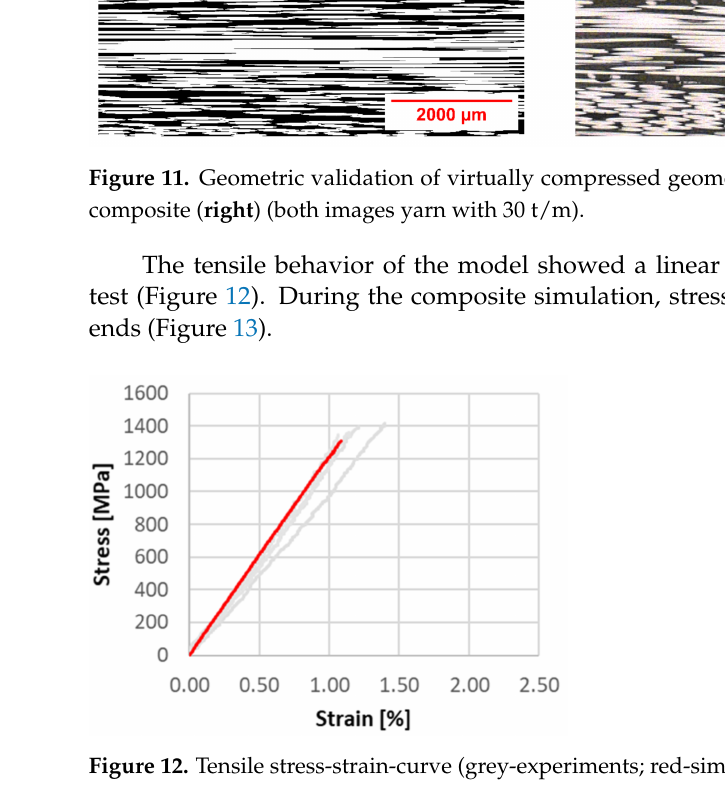
Figure 11. Geometric validation of virtually compressed geometry ( left ) with micrograph of UD- composite ( right ) (both images yarn with 30 t/m).